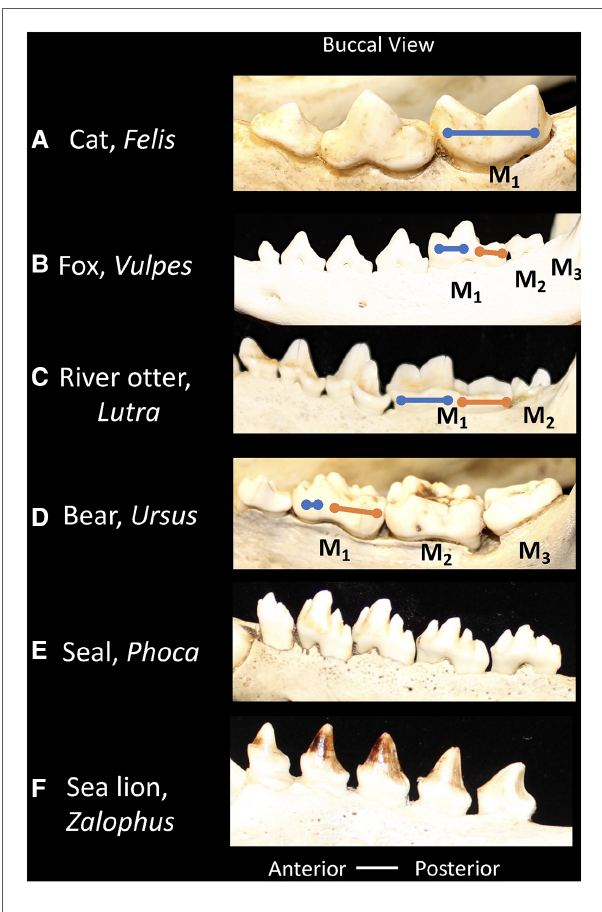
FIGURE 4 Buccal views of the lower postcanine dentitions of carnivorans showing relative proportions of the trigonid (blue line) and talonid (orange line). ( A ) Cat, Felis , the talonid is absent. ( B ) Fox, Vulpes , the trigonid and talonid show similar proportions. ( C ) River otter, Lutra , the trigonid and talonid show similar proportions. ( D ) Bear, Ursus , the trigonid is reduced and the talonid is emphasized. ( E ) Seal, Phoca , the trigonid and talonid are absent. ( F ) Sea lion, Zalophus , the trigonid and talonid are absent. Dentitions are not shown to